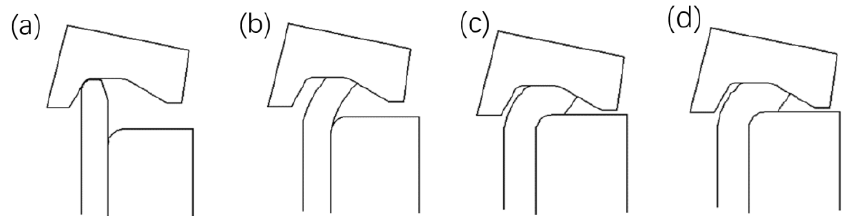
Figure 9. Representative moments during the riveting loading process. ( a ) 0.5 s. ( b ) 2.5 s. ( c ) 3.4 s. ( d ) 3.8 s.